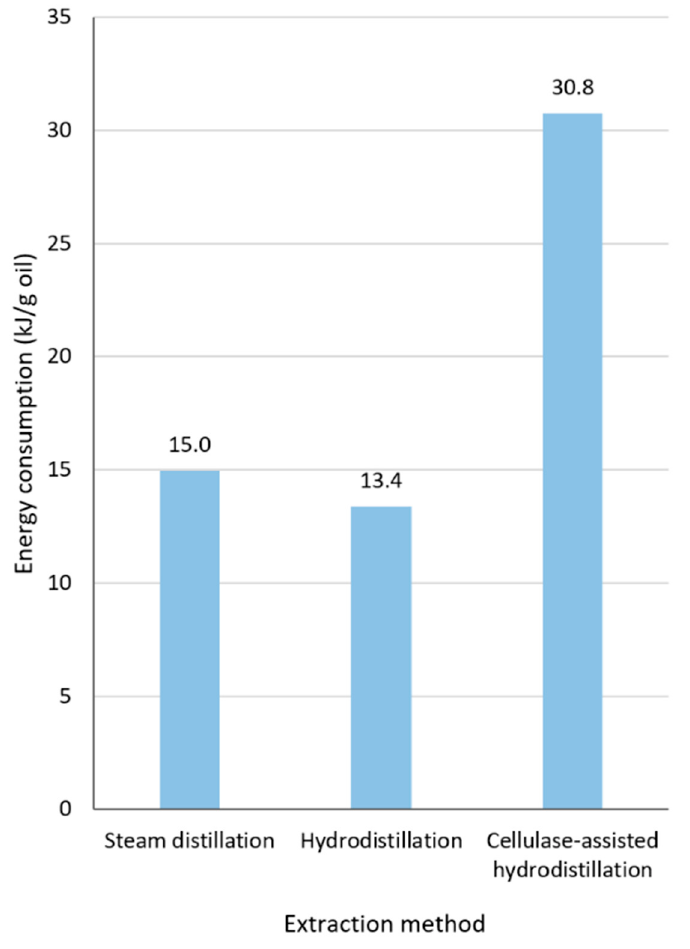
Figure 3. Energy consumption of three different lavender oil extraction methods.